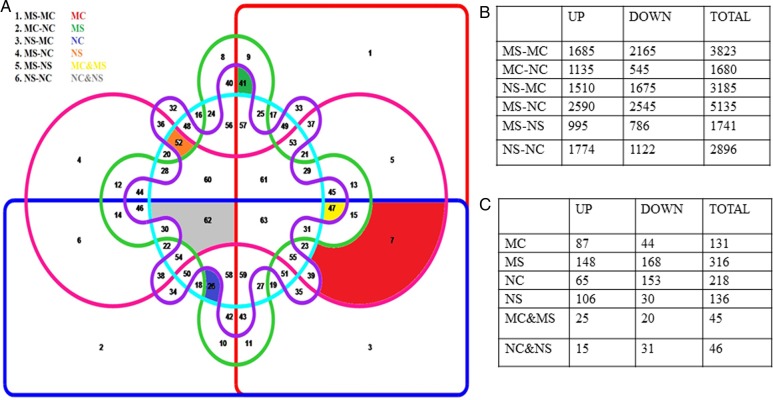
Six-way Venn diagram depicting the number of DEGs in six possible combinations of four samples (NC, Nagina22 control; NS, Nagina22 stress; MC, mutant control; MS, mutant stress). (A) The coloured chambers of the six-way Venn diagram representing uniquely up- and down-regulated differentially expressed genes (URDEGs) out of six combinations (specific colour written for MC, MS, NC, NS, MC and MS and also NC and NS represents specific URDEGs for respective samples). (B) Number of DEGs in six combinations. (C) Number of URDEGs in 12 clusters of similar co-expression.